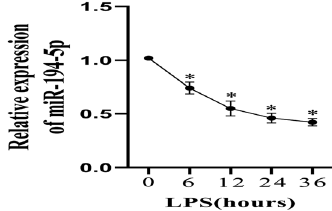
Figure 2: (A) The expression of MiR-22-3p was down-regulated in LPS-treated C28/I2 cells. Total RNAswere extracted from C28/I2 cells or tissue using TRIzol Reagent kit (Invitrogen ™ ) following the manufacture ’ s protocol. The total RNAs were subsequently subjected to cDNA synthesis by using superscript II reverse transcriptase. RT-PCR was performed in the materials and methods section. The asterisk (*) indicates a statistically signi fi cant difference (p-value<0.05).